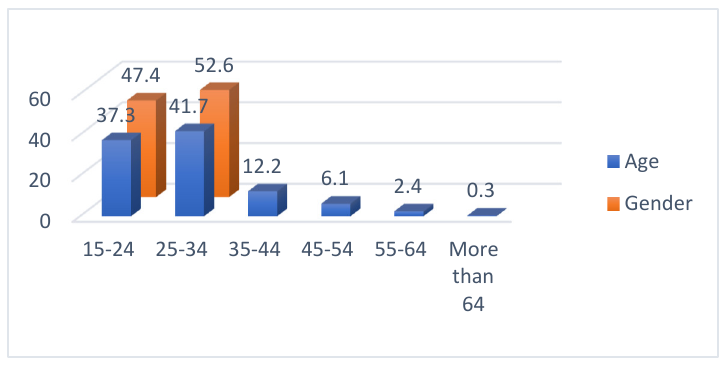
Figure 4. Descriptive Statistics of Age and Gender.